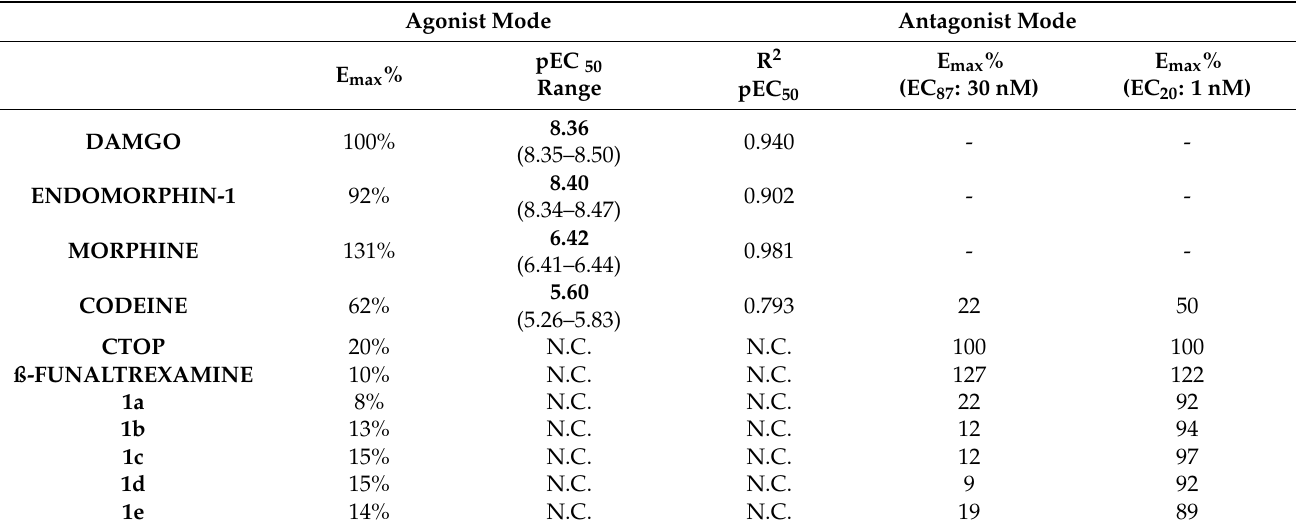
Table 5. Effect of the tested compounds on the recruitment of β -arrestin in U2OS cells with a stable expression of the MOP in the agonist and antagonist modes with two concentrations of DAMGO. Functional data on the recruitment of β -arrestin in the antagonist mode with preincubation of the tested compounds with